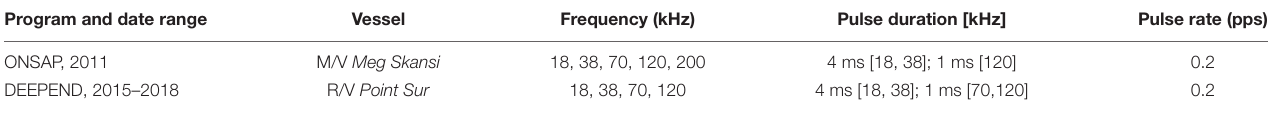
TABLE 2 | Echosounder system properties used during multi-vessel studies in the